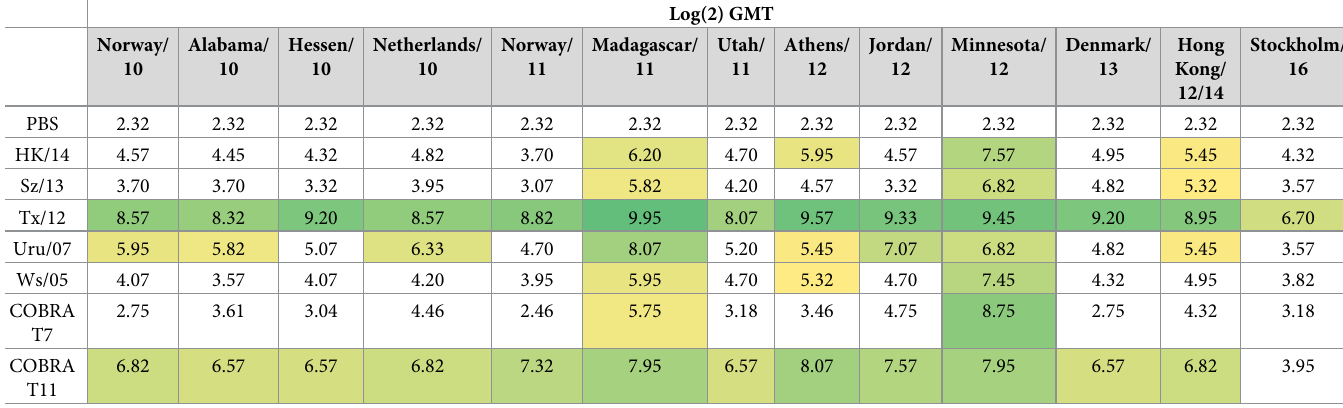
Table 3. Log(2) GMT heatmap: H3 co-circulating strains panel (2010–2016).